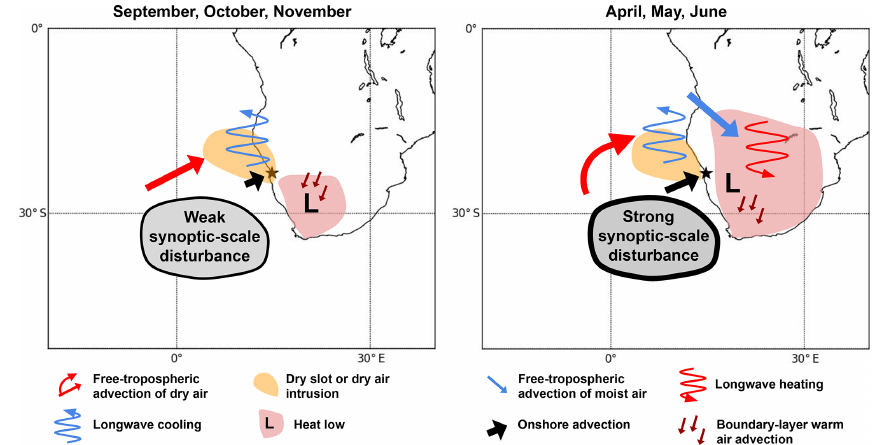
Figure 11. Schematic overview over the synoptical-scale mechanisms that modify day-to-day variability in FLC occurrence in the central Namib during different